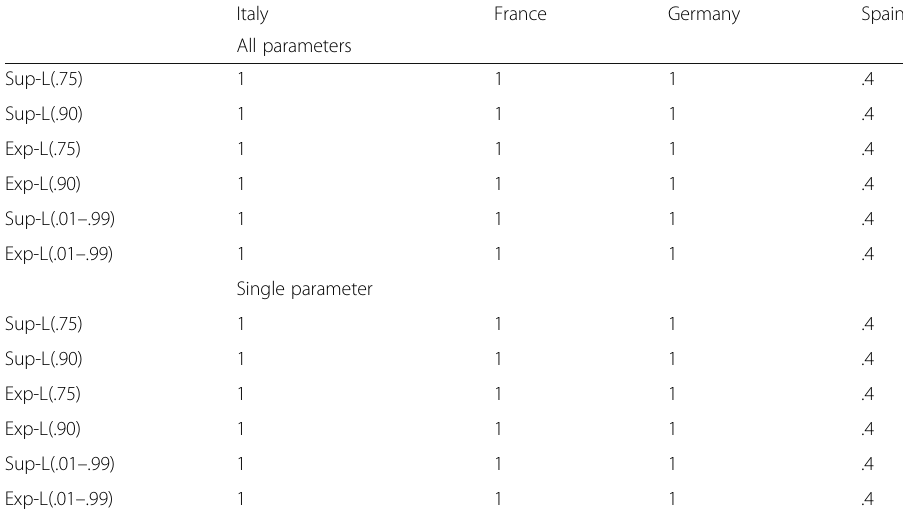
Table 2 End of sample instability test (Eq.